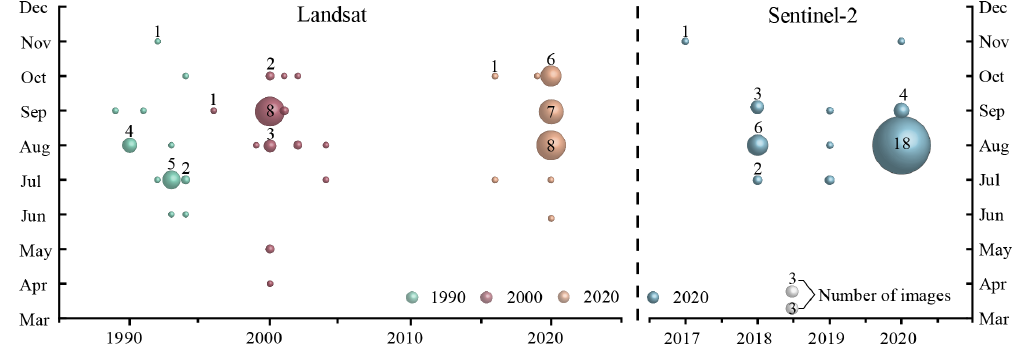
Figure 2. Acquisition of years and months of Landsat and Sentinel-2 images selected for glacial lake inventories. The bubble size indicates the available high-quality image number.